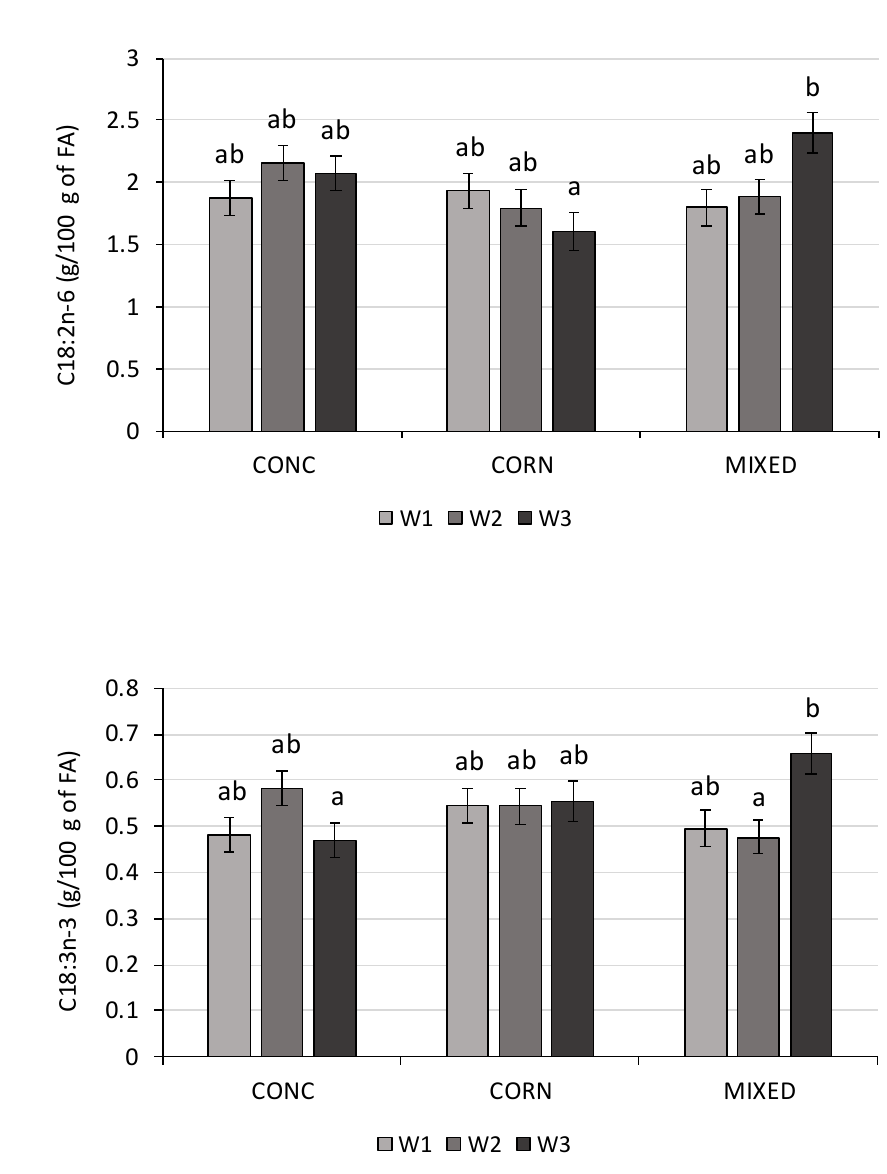
Figure 1. Variation of both the fatty acids (FA): C18 / :2n-6 ( A ) and C18:3n-3 ( B ), between weeks + 1 and + 3 relative to parturition (W1 to W3), in cows with di ff erent dietary treatments (diet based on concentrate meal and straw (CONC), on corn silage (CORN) or corn and grass silages (MIXED)) given during the dry period and receiving the same lactation diet. Values followed by di ff erent letters (a, b) are significantly di ff erent ( p ≤